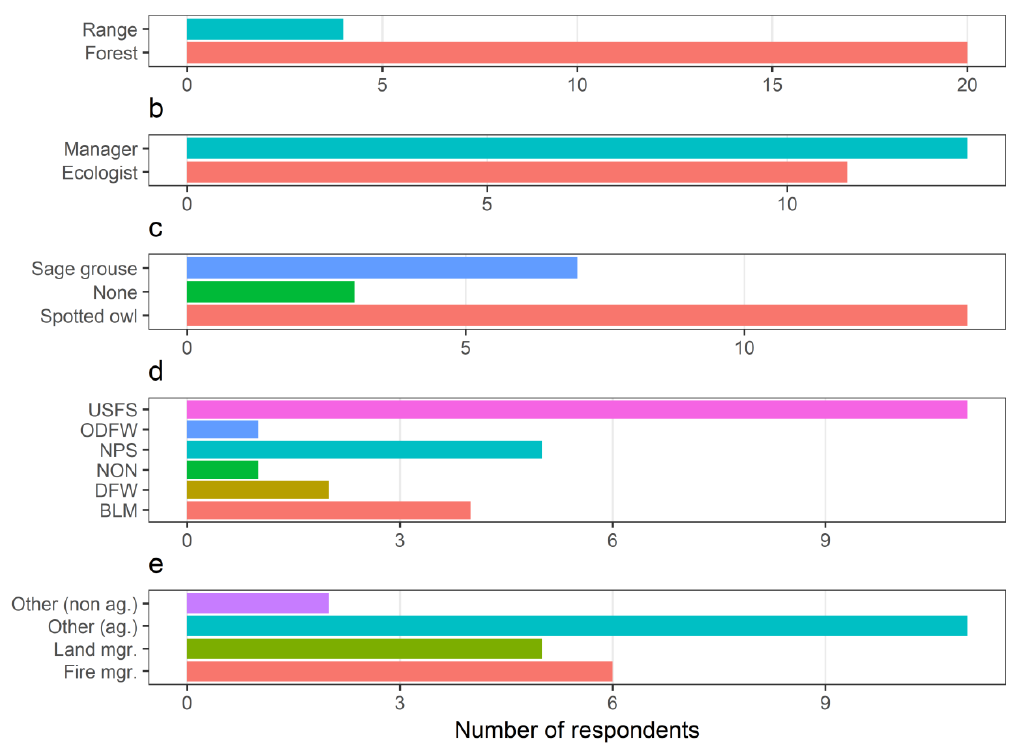
Figure 1. Demographic makeup of survey respondents by ( a ) ecosystem type, ( b ) occupational category, ( c ) refugia species of concern, ( d ) agency, and ( e ) management type.